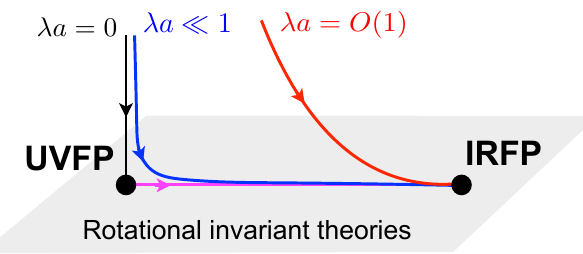
Figure 6 . Various RG (cid:13)ows on the critical surface of the latticized (cid:30) 4 (cid:12)eld theory. All (cid:13)ows with (cid:21) > 0 end up in the IRFP because we tuned the mass to its critical value. However, (cid:13)ows that start with (cid:21)a 1 will (cid:12)rst be attracted to the UVFP and from there move to the IRFP. More precisely, (cid:28) if the quartic coupling is parametrically small at the UV scale a , the RG (cid:13)ow will be controlled by the UVFP until the scale ‘ 0 = 1 =(cid:21) . At this scale, the (cid:13)ow transitions to the neighborhood of the IRFP. The (cid:13)ow with (cid:21) = 0 corresponds to a quadratic theory which ends in the UVFP once the rotation invariance breaking terms have